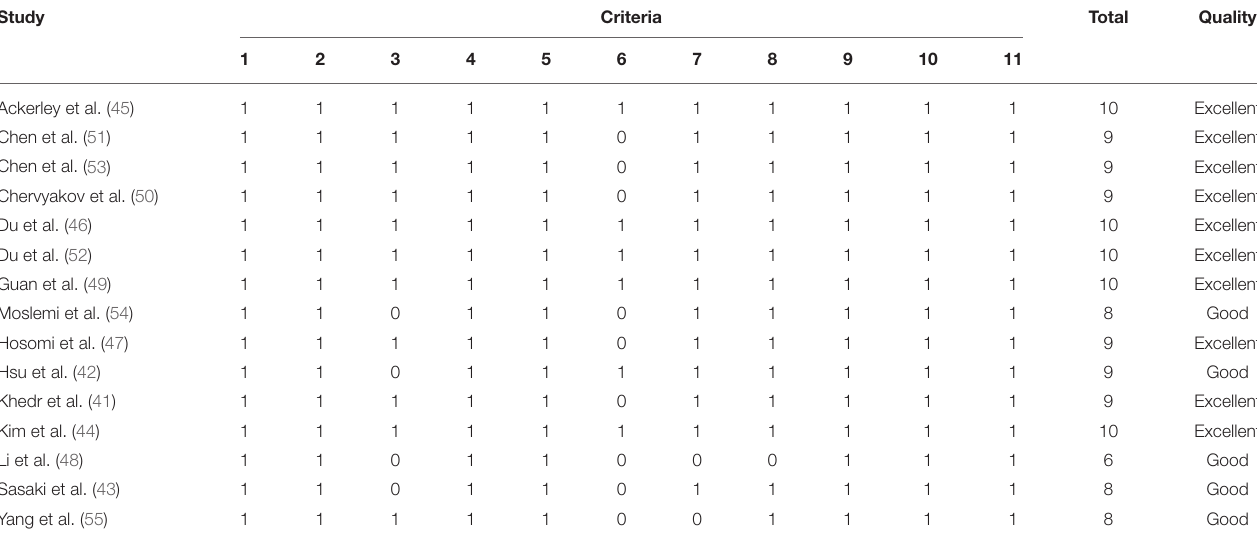
TABLE 2 | Risk of bias assessment according to the Physiotherapy Evidence Database scale.